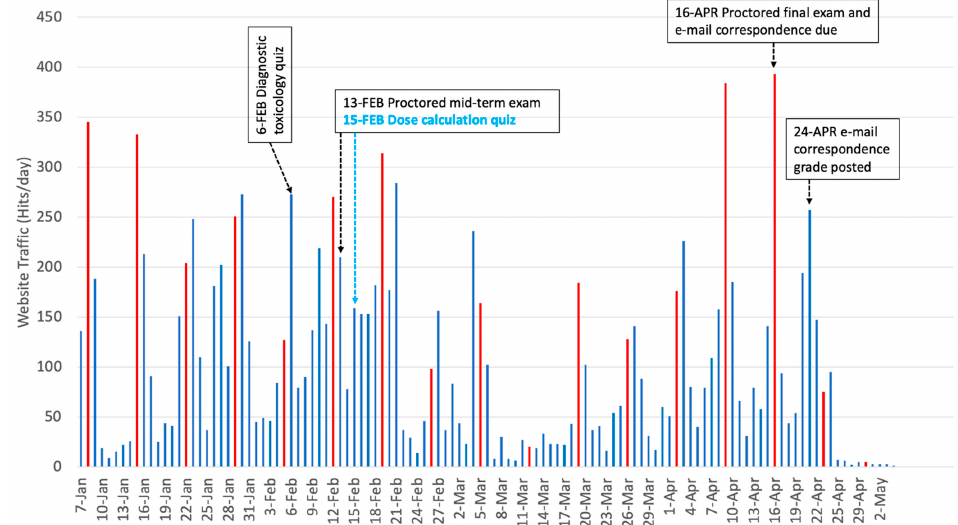
Figure 2. Total number of hits per day on course LMS site for the face-to-face course toxicology course, along with corre- sponding milestone events. Red lines indicate Tuesdays when maximum access to the course materials occurred. Note that the y-axis scale does not match that used in Figure 1.